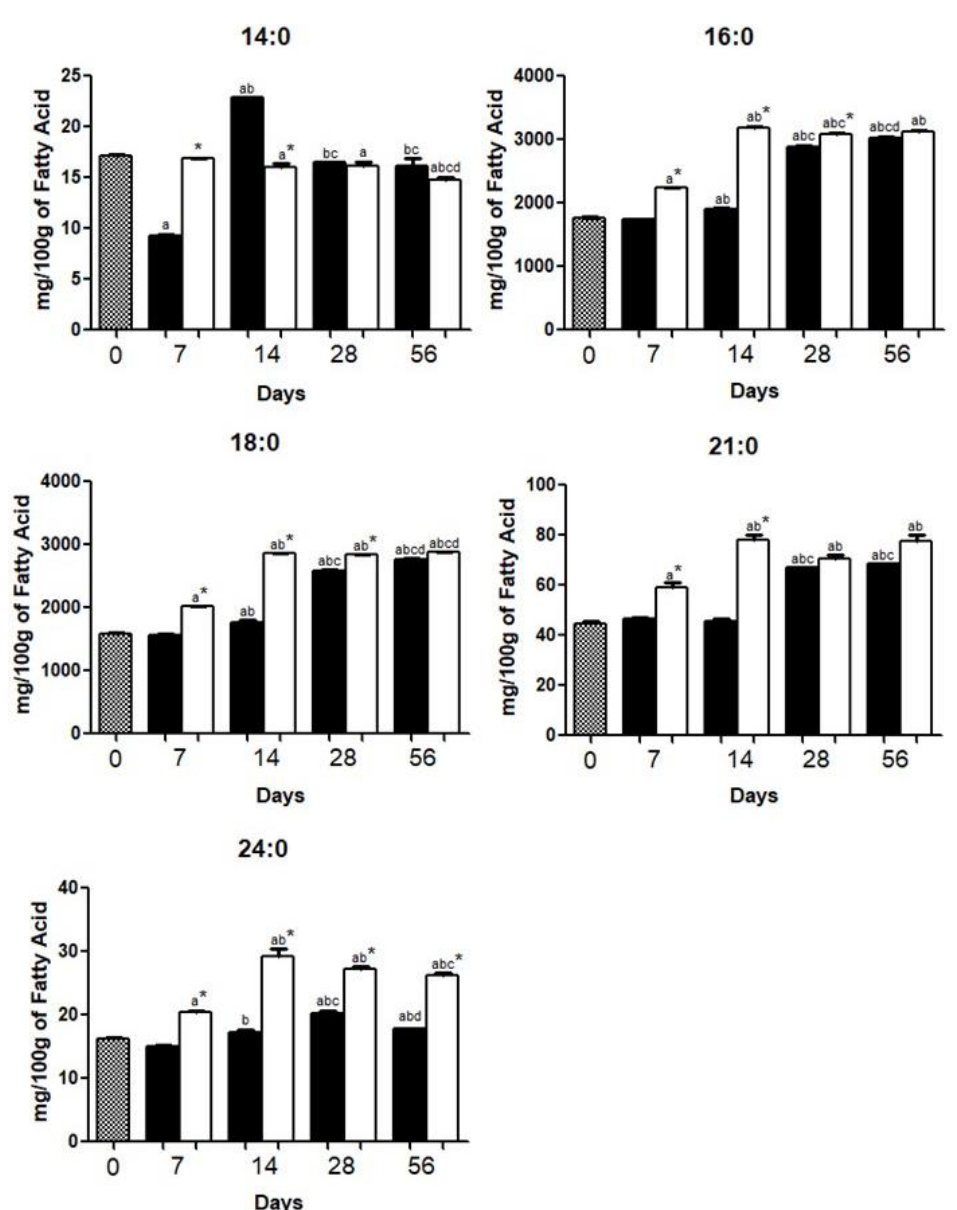
Figure 1. Saturated fatty acid (SFA) composition in the brains of mice fed a high carbohydrate diet (HCD) or high fat diet (HFD) before (day 0) and 7, 14, 28, or 56 days after onset of diet administration. The concentrations of myristic acid ( 14:0 ), palmitic acid ( 16:0 ), stearic acid ( 18:0 ), heneicosanoic acid ( 21:0 ), and tetracosanoic acid ( 24:0 ) were expressed as the mean ± standard deviation of three replicates for each group. p < 0.05 as compared with day 0 ( a ), day 7 ( b ), day 14 ( c ), and day 28 ( d ), and HCD group*.